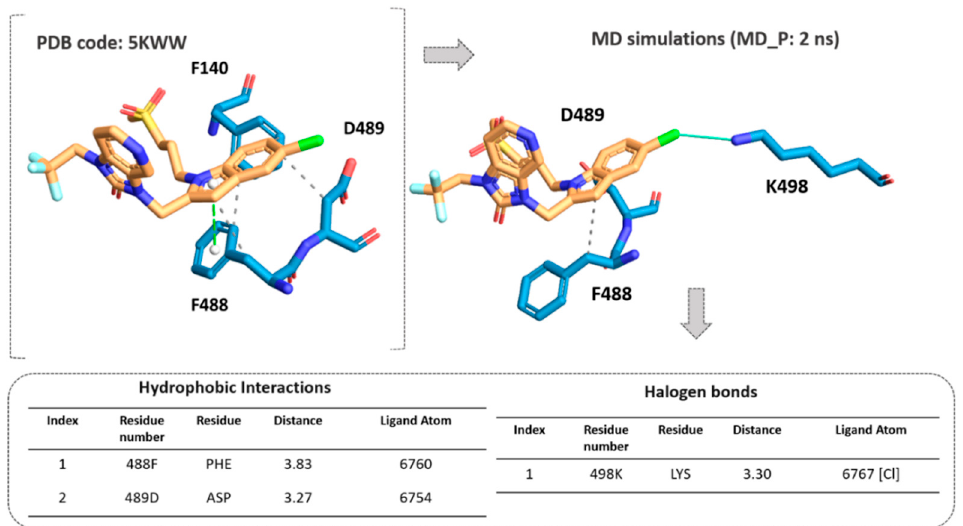
Figure 10. Comparison of the X-ray data of JNJ-53718678 at the F protein surface (pdb code = 5KWW) with the positioning featured by the inhibitor based on MD simulations, MD_P. The related key contacts observed after 2ns of MD_P are shown as tables. Distance values are reported in Å.